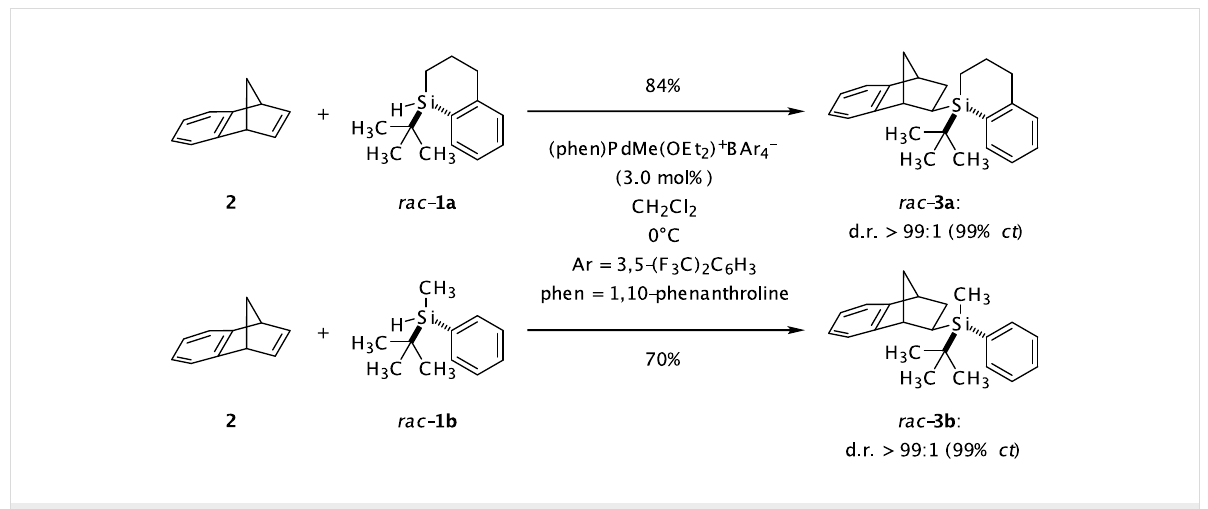
Scheme 1: Cyclic and acyclic chiral silanes as potent reagents for the silicon-to-carbon chirality transfer.